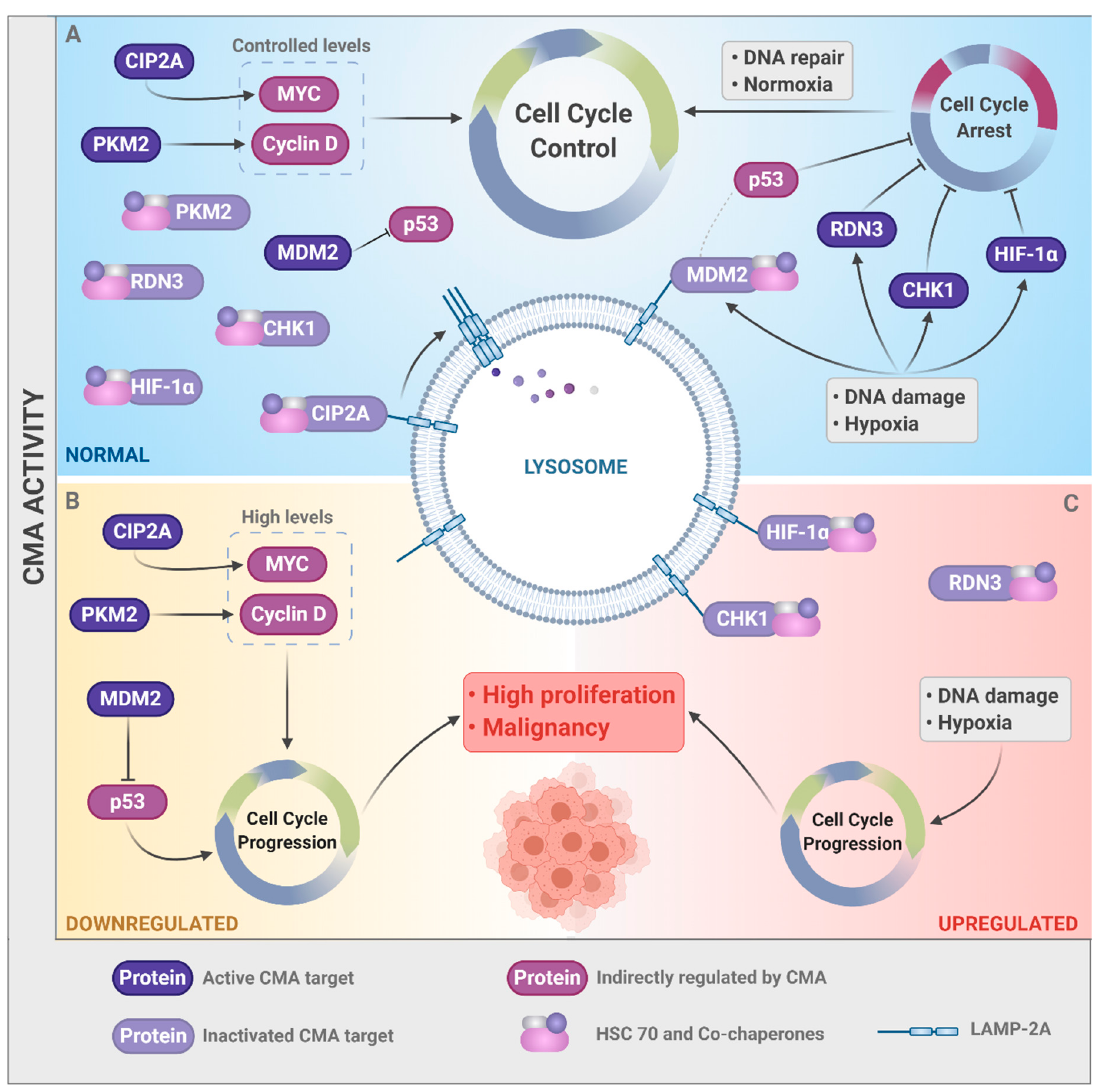
Figure 3. CMA activity controls the cell cycle and cancer. ( A) In physiological conditions, CMA controls the levels of both positive (e.g., MYC and Cyclin D1) and negative (e.g., RDN3, CHK1, and HIF-1 α ) cell cycle regulators. ( B) With low CMA activity, CIP2A and MDM2 are not degraded, which consequently increases the levels of MYC and decreases those of p53, promoting high proliferation and an increase in genetic instability. ( C ) High CMA activity leads to excessive degradation of the negative regulators of the cell cycle under stressful conditions (CHK1, HIF-1 α , and RND3), leading to disorderly growth. ( B , C ) Therefore, both scenarios (downregulation or upregulation of CMA) can result in malignancy. Figure created with Biorender.